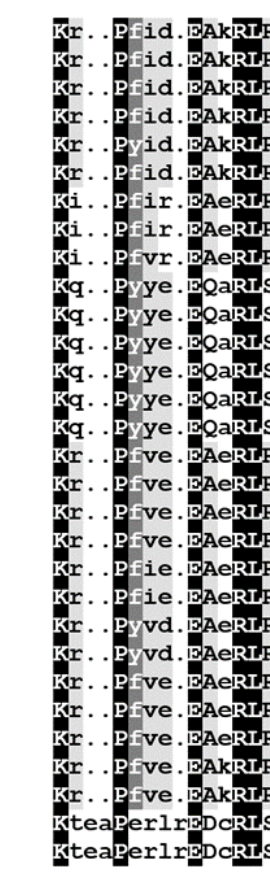
Figure 4. Conserved domain pattern in Sox proteins across Bos sp.